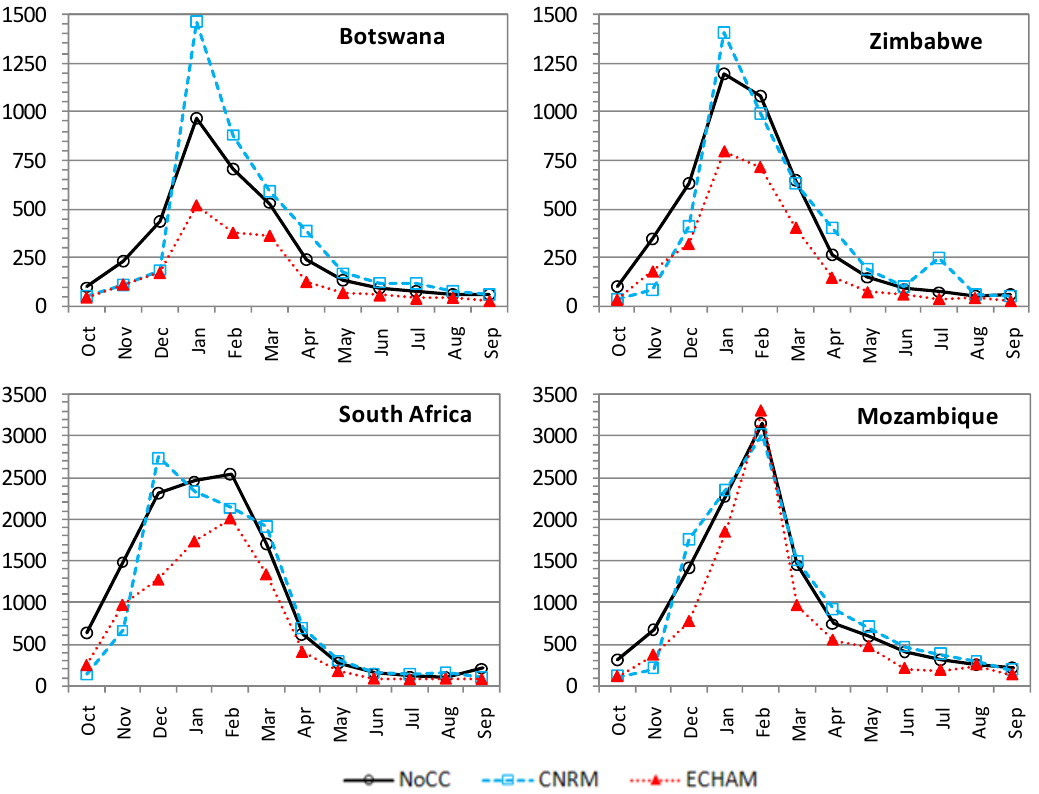
Figure 13. Monthly mean runoff (10 6 m 3 ) under the 1971–2000 climate baseline and climate change scenarios for